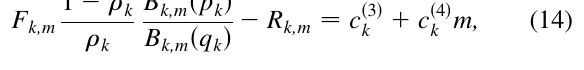
FIG. 4. Fraction of triples that are of the S - I - S type, for SI dynamics on a three-regular random